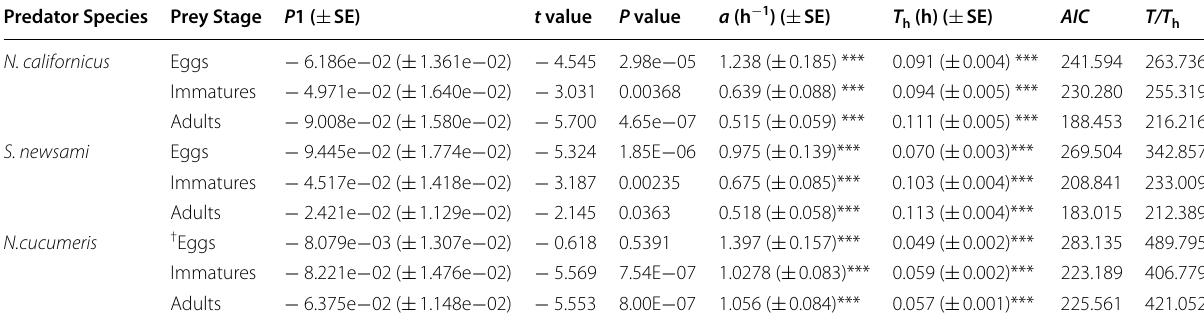
Table 3 Results of logistic regression to denote functional response type across predatory mites by feed on three life stages of P. citri using Holing’s disc equation